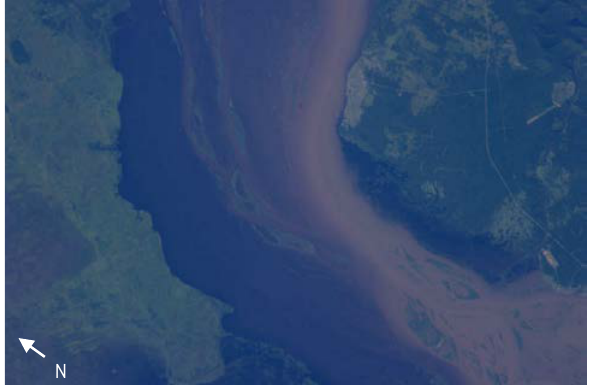
Figure 3. Astronaut photograph ISS036-E-34510 acquired on 21 August 2013 in response to IDC activation for flooding of the Amur River in eastern Russia.